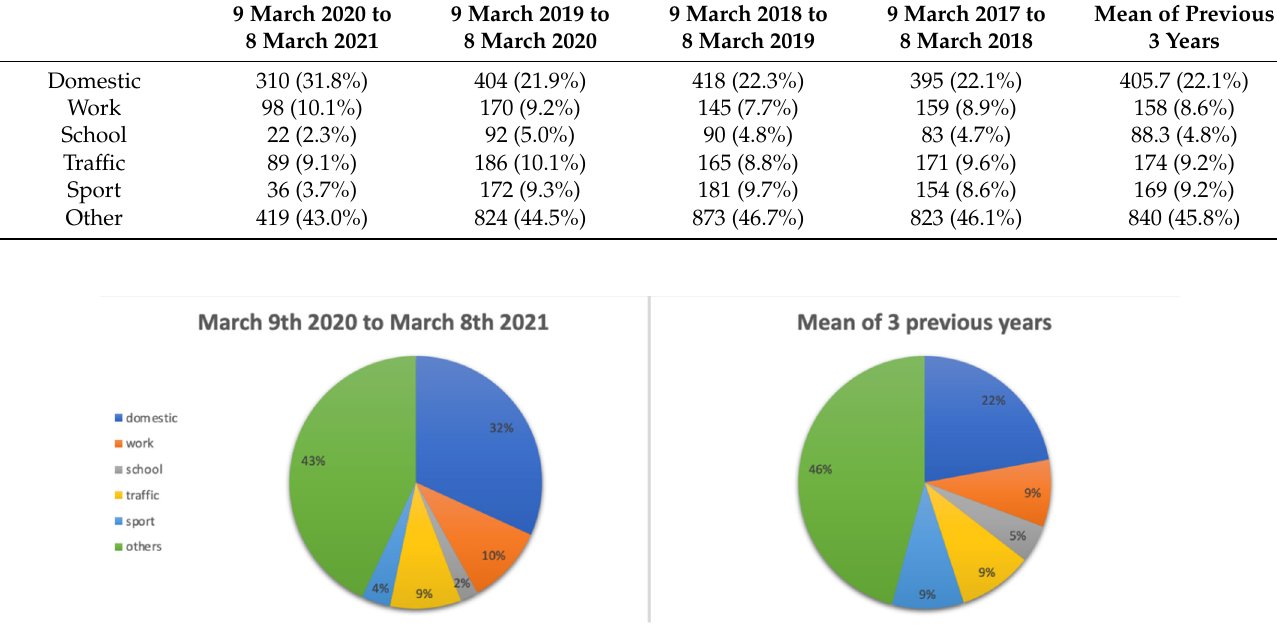
Figure 2. Causes/places of hand injuries of people reaching the authors’ ED before and during the COVID-19 pandemic. Table 3. Type of lesions.